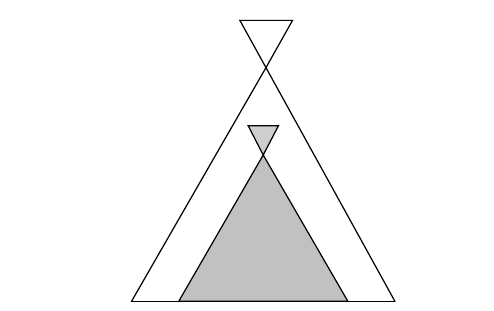
Table 2. Flying height, image size and foot print at GSD=10cm